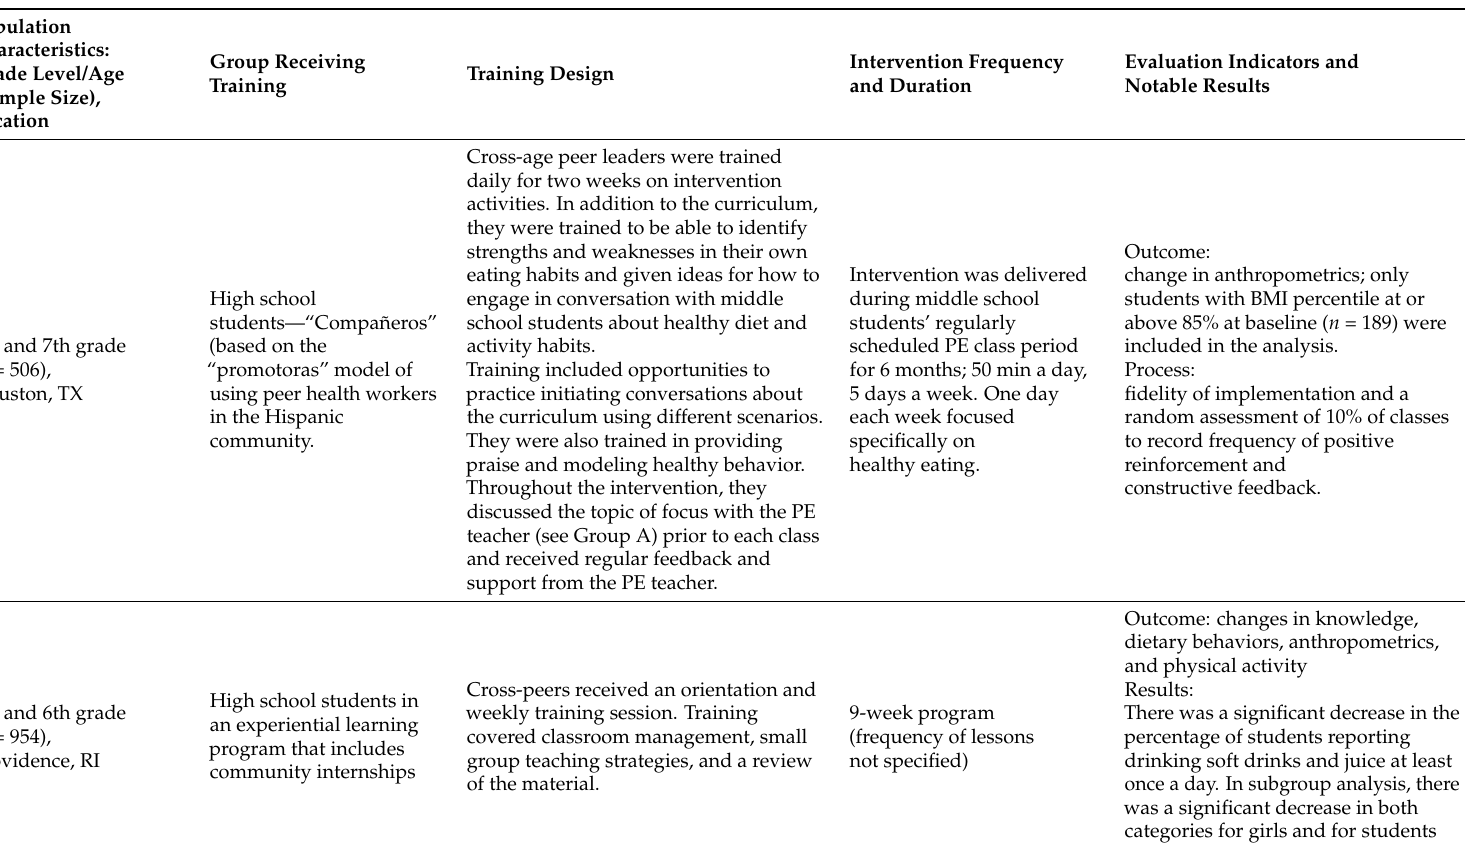
Table 3. Group B: Classroom-based interventions that trained cross-age